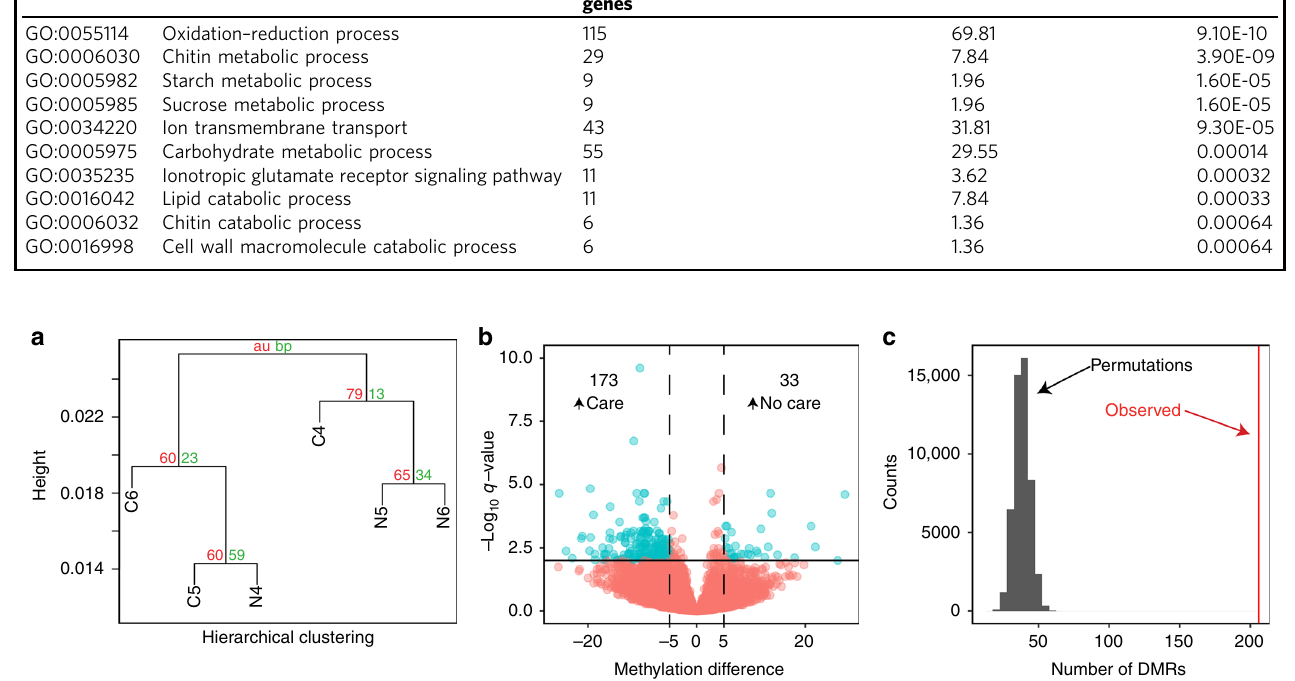
Fig. 3 Loss of maternal care leads to localized, signi fi cant changes in DNA methylation. a Hierarchical clustering of gene level measures of DNA methylation ( n = 19,361 genes) using the “ complete ” method with correlation-based distances reveals no global clustering by sample type (N, no care; C, care), with low support values using both the approximately unbiased (au) and bootstrap probability (bp) statistics. Thus, this tree can be considered one polytomy. Similar results are obtained when clustering only methylated genes. b Volcano plot showing the 200 bp regions considered differentially methylated (blue) and those not considered signi fi cant (red), as well as the thresholds used to de fi ne these categories (black lines). Methylation difference is given as a percentage. c Quadratic Assignment Protocol computed null distribution for the number of DMRs possibly occurring randomly using 50,000 randomized permutations and the associated number of experimental DMRs. The red line indicates the observed number of